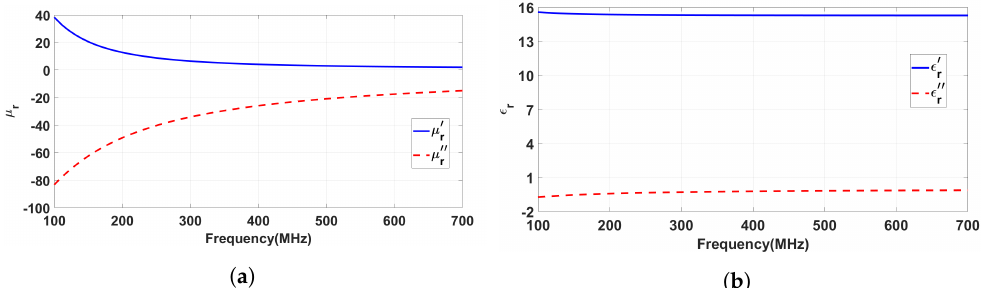
Figure 3. Debye model of the ferrite: ( a ) relative permeability and ( b ) relative